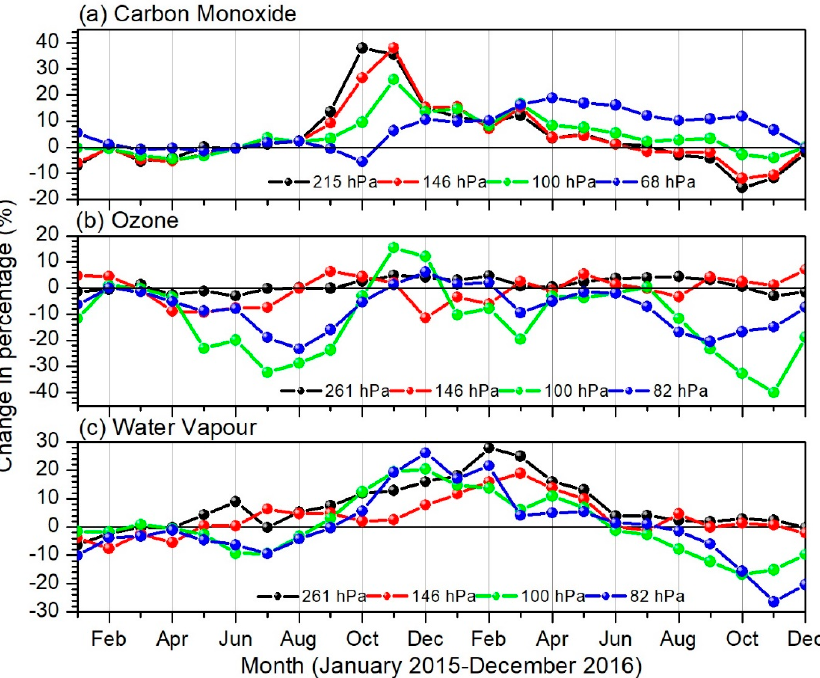
Figure 11. Percentage change with respect to the background climatology (2006–2014) in ( a ) carbon monoxide, ( b ) ozone and ( c ) water vapour observed over equatorial region (averaged over 10°S–10°N). Different colours represent different pressure levels.